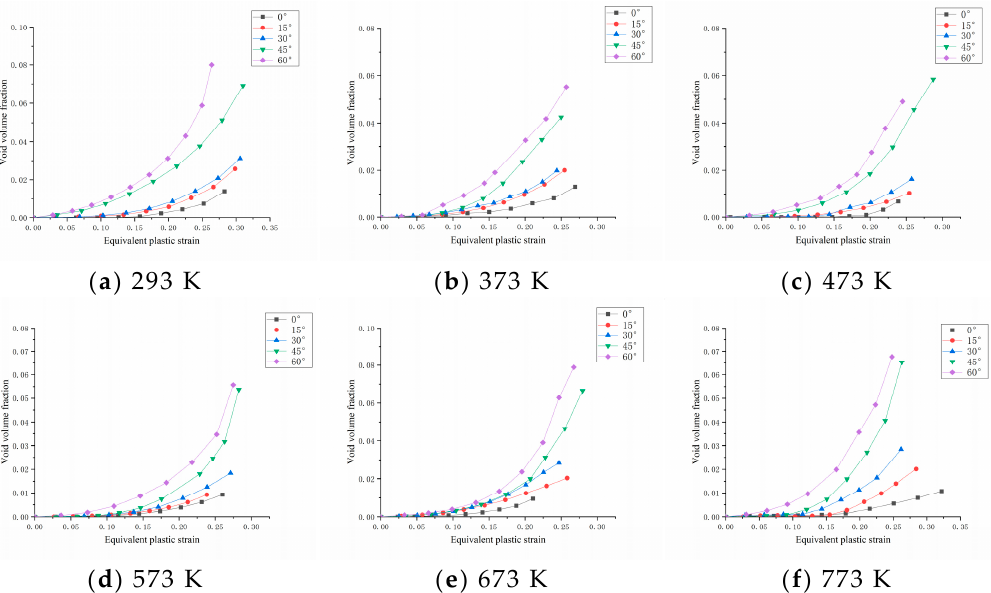
Figure 18. VVF and equivalent plastic strain diagram at different temperatures ( a – f ).